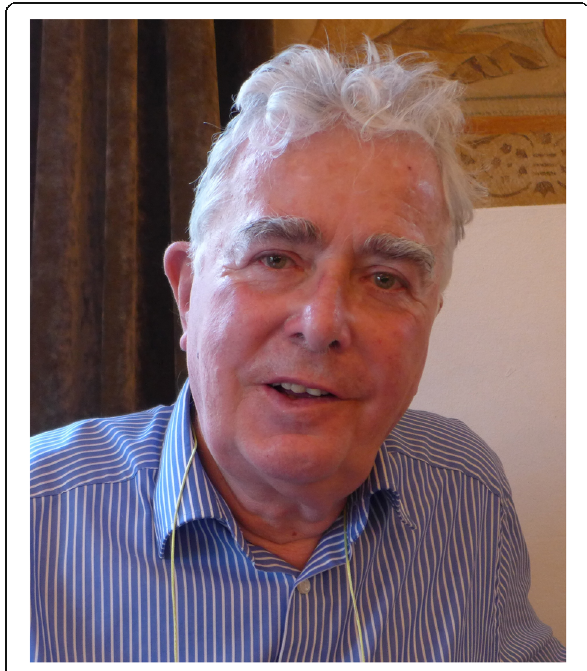
Fig. 13 Hannes Hertel in his Munich home, 24 October 2019.